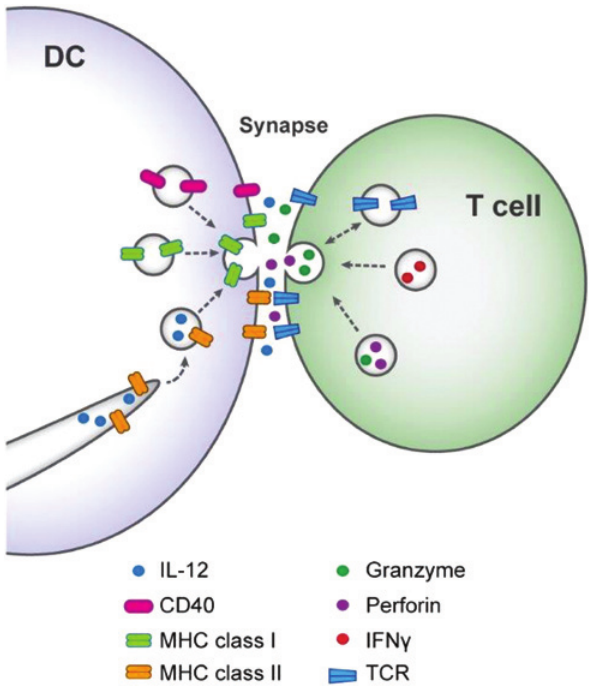
Figure 3: Scheme of membrane trafficking to the DC and T cell sides of the immunological